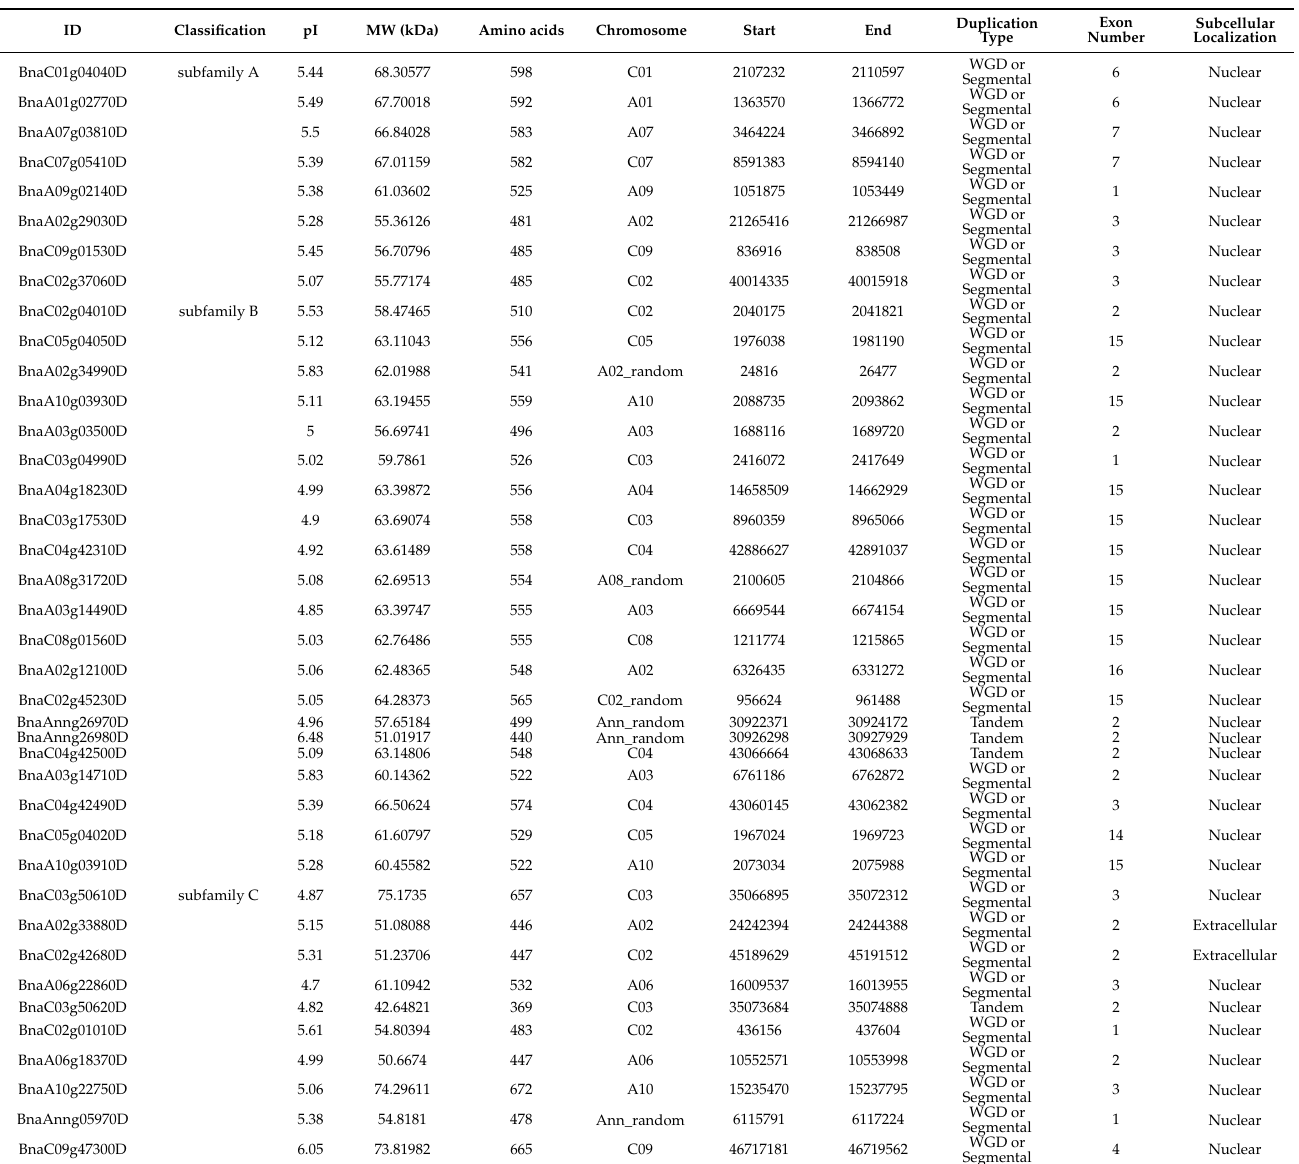
Table 1. Characteristics of the ARI genes in B. napus (pI, isoelectric point; MW, molecular